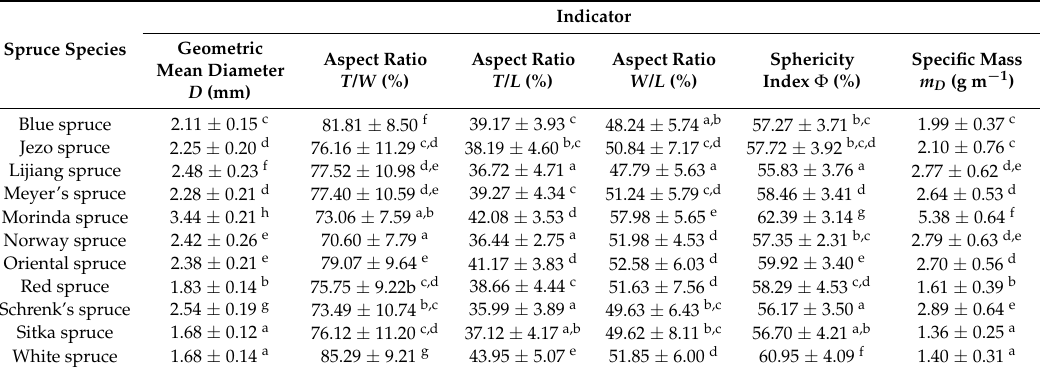
Table 2. Statistical distribution of the calculated indicators (mean value ± standard deviation) of seeds in selected spruce species and significant differences between